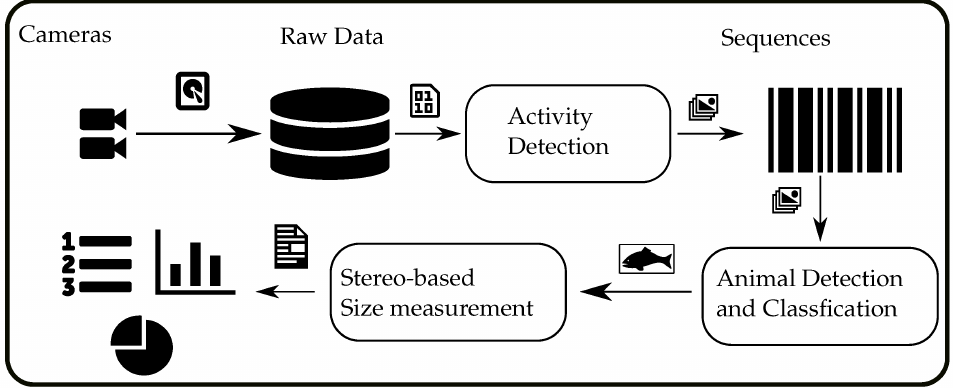
Figure 3. The processing pipeline from the recording of underwater videos to the final biomass